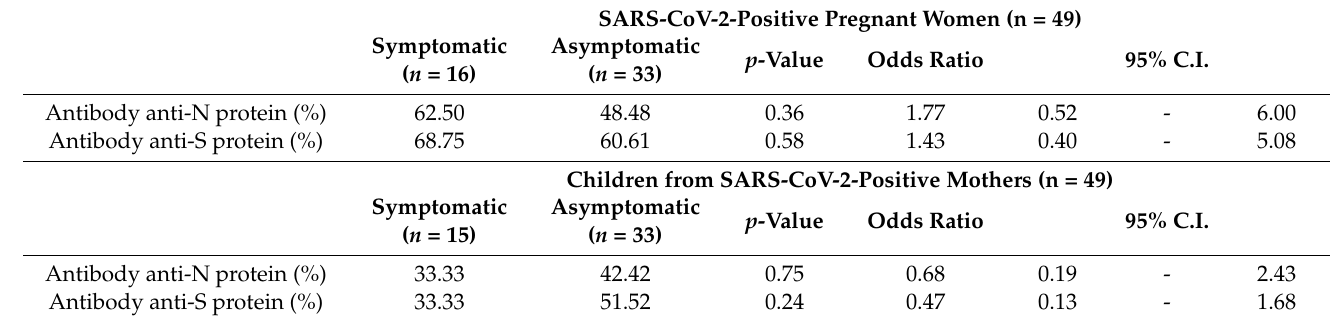
Table 3. Presence of Anti-N and Anti-S antibodies towards SARS-CoV-2, associated with COVID-19 symptoms, in pregnant women and their